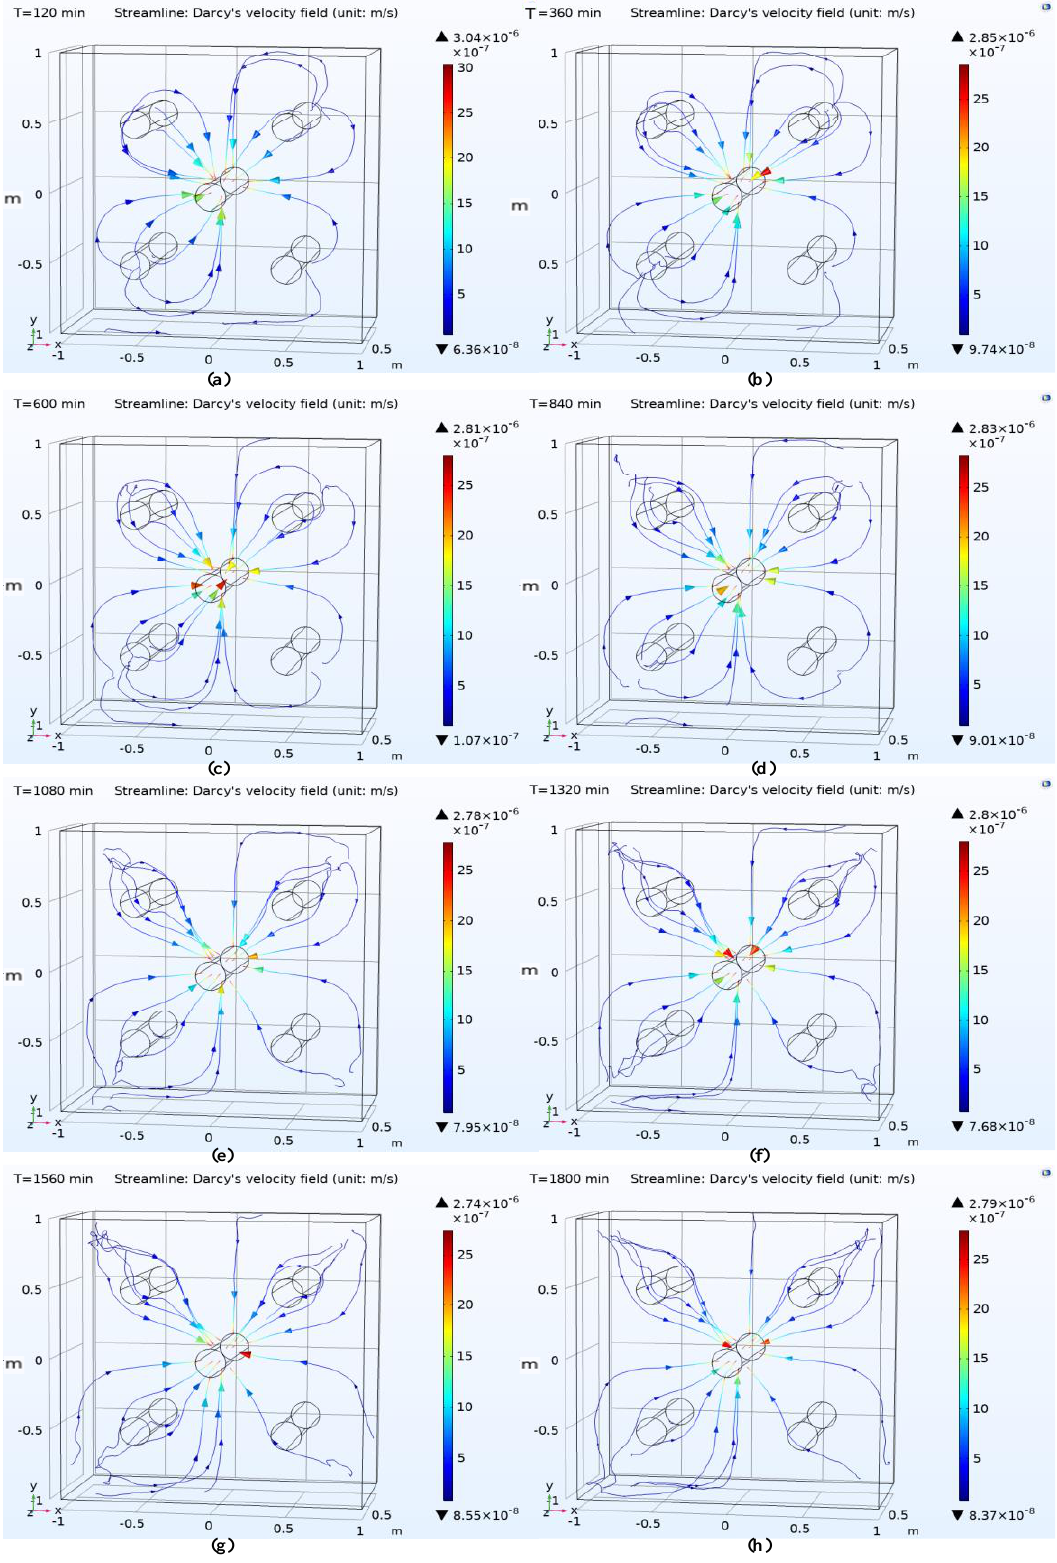
Figure 8. Distribution of velocity field versus time for coupled simulation. Subfigures ( a – h ) use streamline to represent the fluid velocity distribution in porous media every 4 hours after the second hour of simulation. The speed value is given by the legend, and the speed direction is the same as the arrow direction.